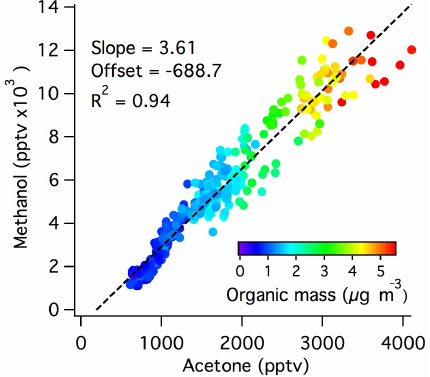
Figure 2. Correlation of methanol and acetone measured by PTR- ToF-MS. The colour scales represent the total organic mass mea- sured by